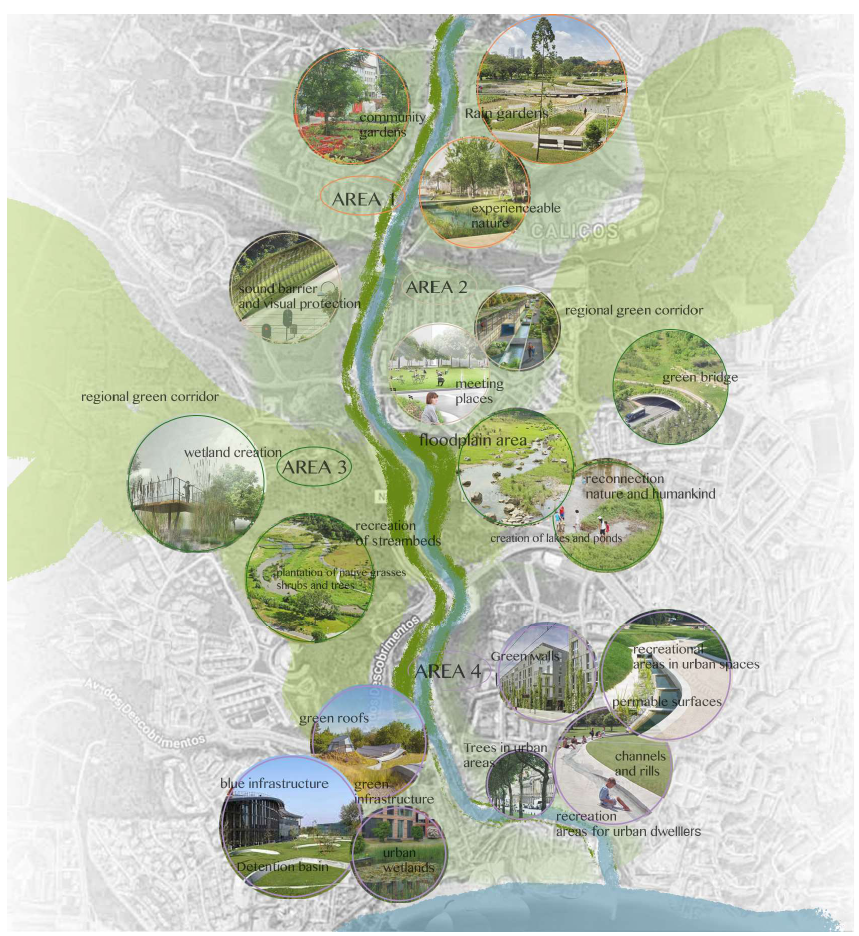
Figure 4. The concept of Albufeira’s green corridor linear park.